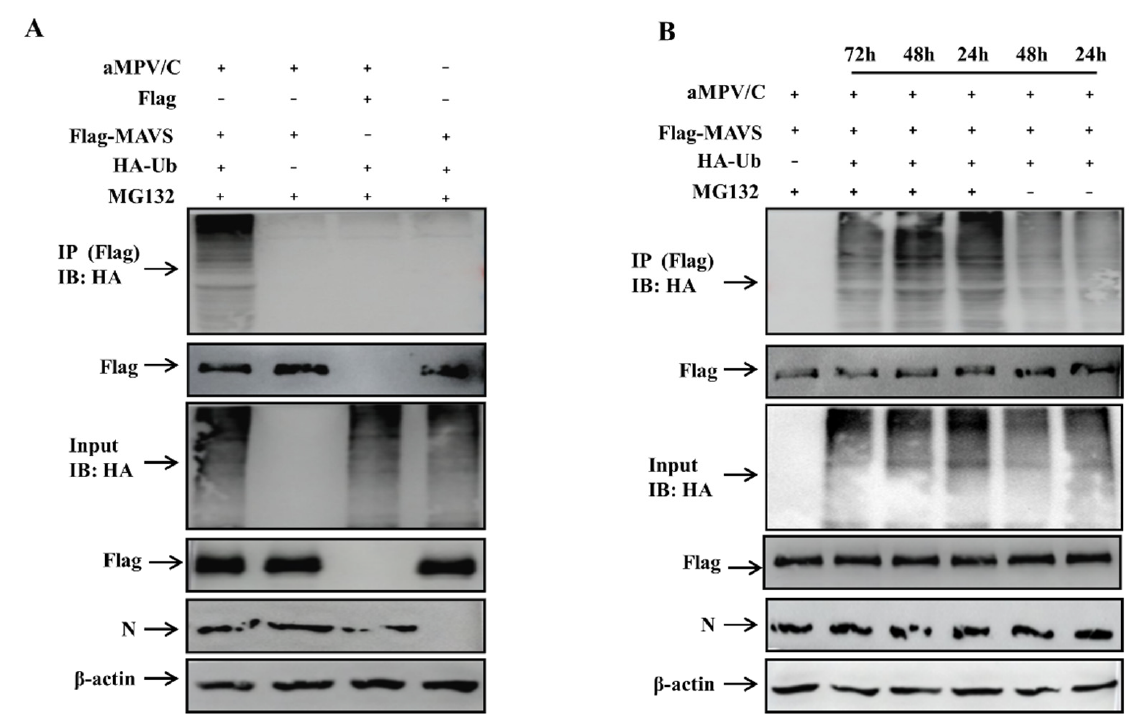
Figure 3. MAVS polyubiquitination is analyzed in aMPV/C-infected or Mock-infected Vero cells. ( A ) Vero cells were co-transfected with Flag-MAVS and HA-Ub. After 6 h transfection, the cells were infected with aMPV/C (MOI = 0.5) for 48 h in the presence of MG132, and analyzed by IP with anti-Flag antibody or Western blot with anti-HA antibody. In addition, Flag, HA and β -actin in aMPV/C-infected cells detected by immunoblotting were used as an input control and an internal loading control, respectively. aMPV/C infection was verified with antiviral N antibody. ( B ) Vero cells were co-transfected with Flag-MAVS and HA-Ub. After 6 h transfection, the cells were infected with aMPV/C (MOI = 0.5) for 24, 48, or 72 h in the presence of MG132, and analyzed as described in A.